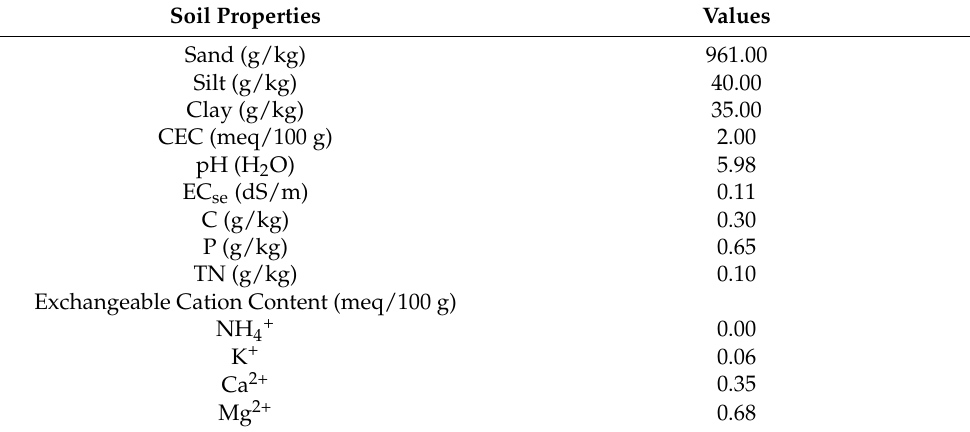
Table 1. Physicochemical properties of sanddune soils. Soil Properties Values Sand (g/kg)